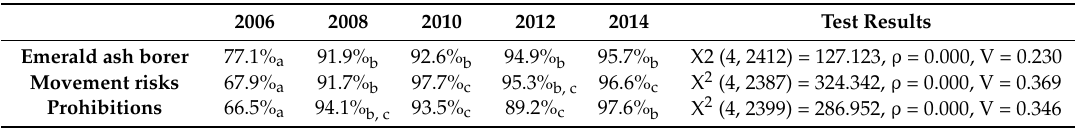
Table 1. Camper awareness of firewood related issues †, ♦